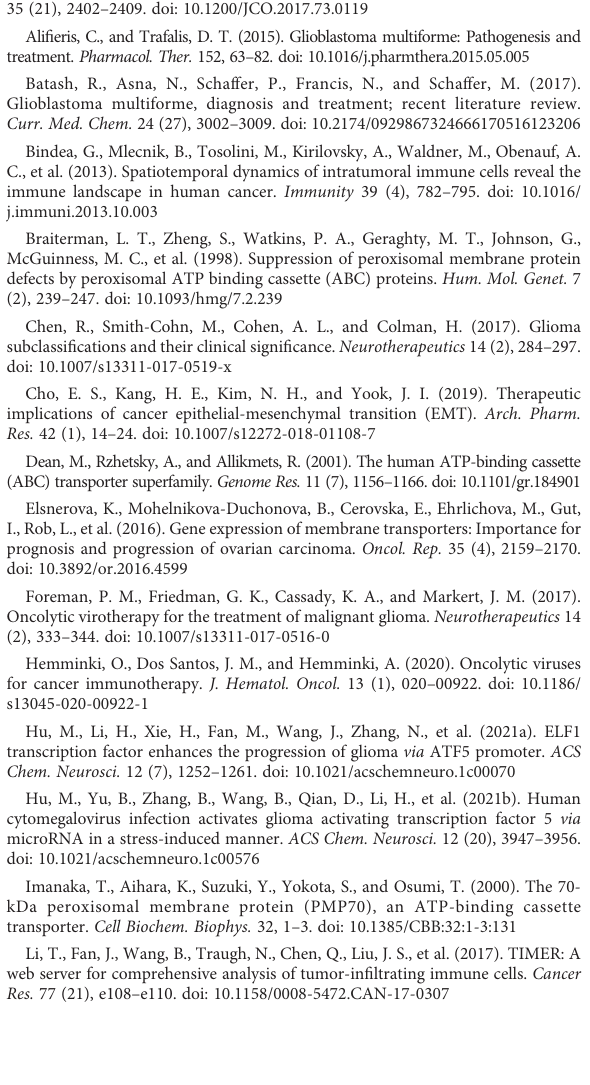
SUPPLEMENTARY FIGURE 1 A high level of quality and suf fi cient quantity of data wastested by FastQC. The FastQC resultscon fi rmedahighlevel of qualityandsuf fi cient quantity for further gene functional analysis. SUPPLEMENTARY FIGURE 2 ABCD3 expression is associated with glioma grades and survival rate from CGGA. (A) ABCD3 expression is associated with glioma grades. (B) Overall survival curve of all grade primary glioma based on differential ABCD3 expression. SUPPLEMENTARY FIGURE 3 ABCD3 different expression with glioma subgroups. ABCD3 did not display a statistical different expression in patient Gender (A) and Age (B)